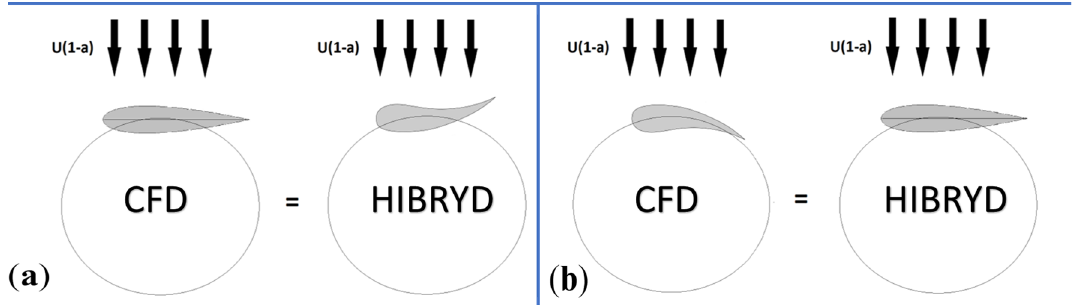
Figure 8. Qualitative equivalence between ( a ) CFD symmetrical airfoil and hybrid model with virtual camber and ( b ) CFD cambered airfoil and hybrid model without virtual camber.